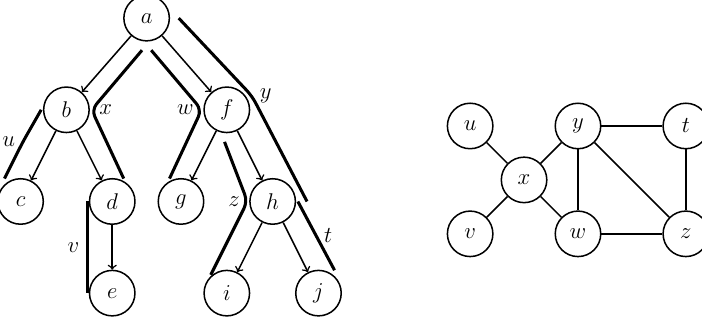
Fig. 3: At the right hand side, this figure shows an example of a rooted directed path graph. At the left hand side, this figure shows a rooted directed path representation of the graph. An inverse DFS on that tree is ( j i h g f e d c b a ) inducing the following order of the vertices of the graph: ( t z y w v x u )